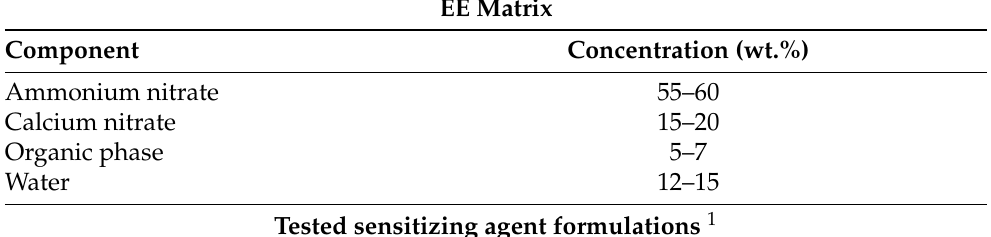
Table 1. Summary of the components of the tested explosive